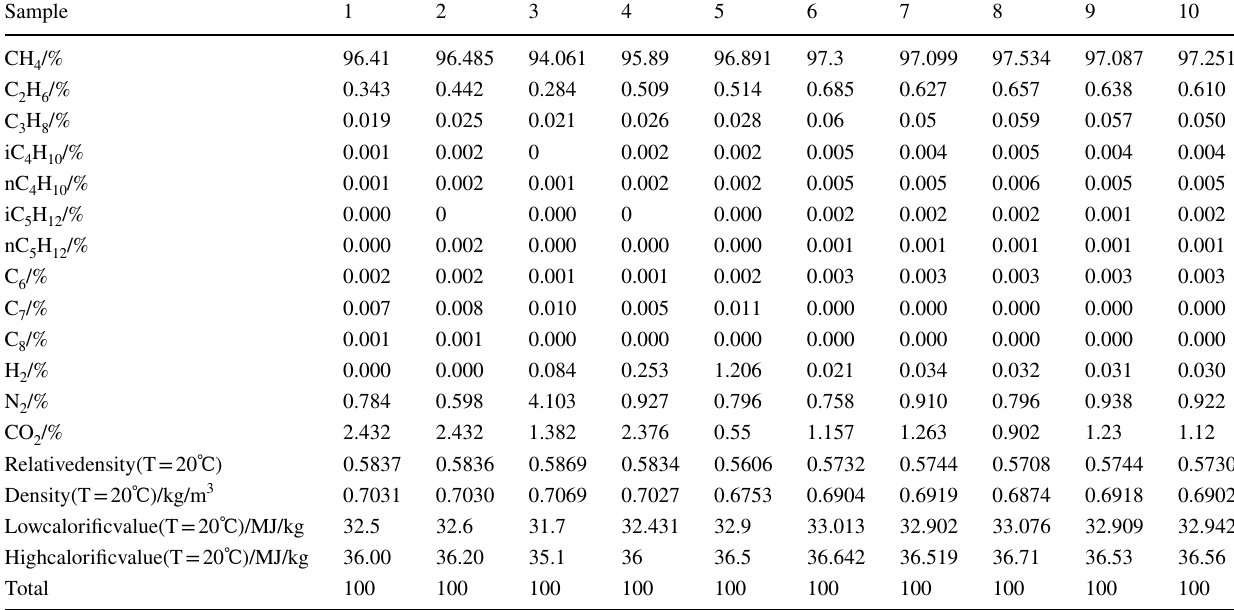
Table 2 Composition of 30 groups of natural gas samples-a Sample